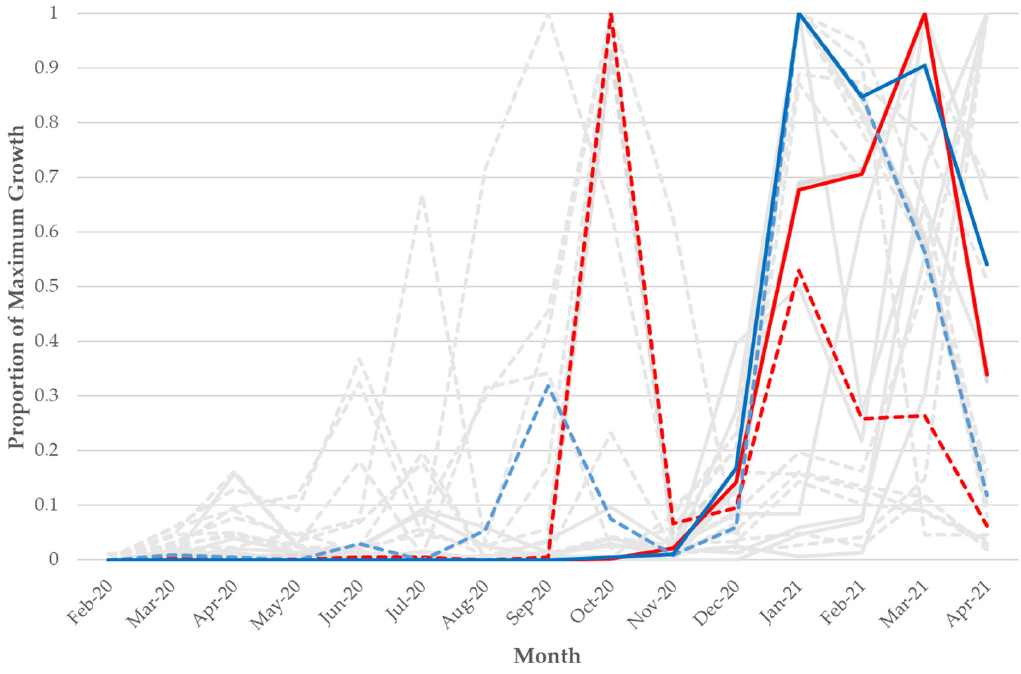
Figure 3. Frequency over time of the n = 15 VoC/VoI mutations that had a substantial increase as a minor variant prior to a rise as a fixed variant across 411,805 NCBI SRA SARS-CoV-2 samples. The Y-axis is scaled by the maximum count for each particular mutation and scaled separately for minor variant and fixed mutations. Dotted lines represent minor variant mutations and solid lines repre- sent fixed mutations. The red solid and dotted lines represent the A23063T/N501Y mutation/change, and the blue solid and dotted lines represent the T22917G/L452R mutation/change. The grey lines represent the other 13 VoC/VoI mutations that had a substantial increase as a minor variant prior to a rise as a fixed variant (each is also found in Figure S1). Of the mutations that were screened for by iSKIM, 50.5% were located on the Spike gene. 36.4% were not located on any of the four structural genes. However, 73.3% of the mutations that peaked as candidate minor variants prior to their fixed variants’ peaks were located on the Spike gene (Table 3) which was significant (one-proportion z-test, p = 0.0387). Of the mutations that had no substantial number of samples containing the mu- tation as minor variants despite a substantial rise in the number of samples containing the mutation as fixed variants, 64.7% of the mutations were not located on structural genes, which was also significant (one-proportion z-test, p = 0.0765). Mutations that are located on non-structural genes are more likely to fall into the category of having no substantial rise in minor variant presence paired with a substantial rise in the number of fixed vari- ants. Table 3. n = 15 VoC/VoI mutations that appeared as candidate minor variants prior to becoming fixed variants were mostly associated with the spike protein including on the NTD and RBD protein domains. ‘X’ denotes which lineage(s) each mutation is predominantly found in. Mutations of Concern (Amino Acid Notation) Protein Segment